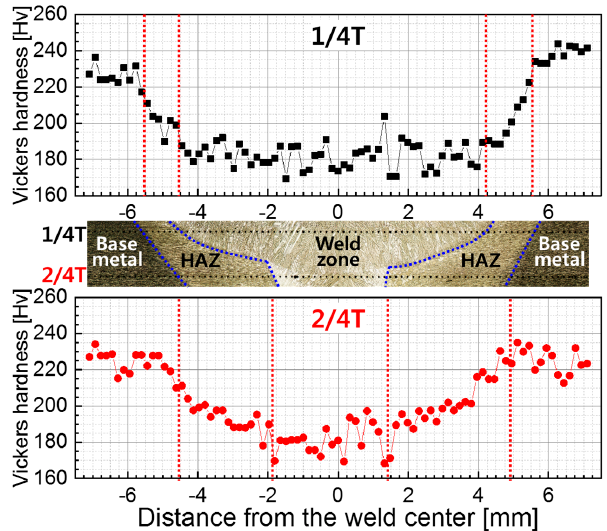
Figure 7. Vickers hardness profiles of the present high Mn steel ranging over welded joints regions.